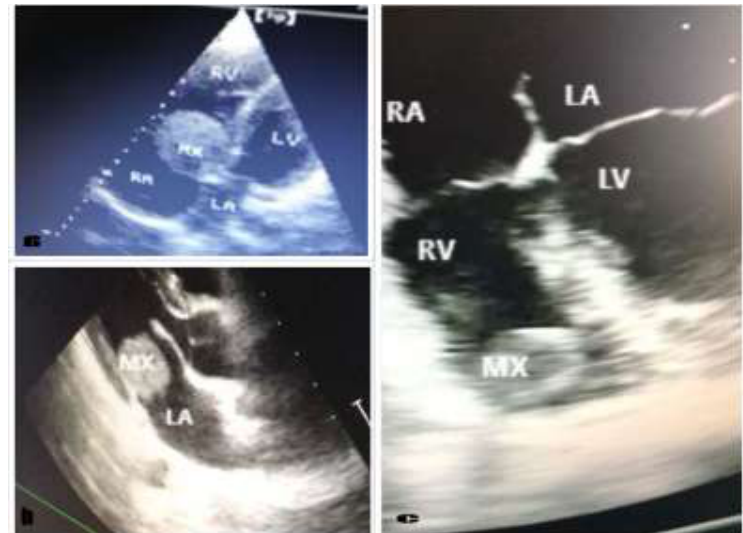
Figure 1. Two-dimensional transthoracic echocardiogram of right atrial myxoma (a), left atrial myxoma (b), and right ventricular myxoma (c)